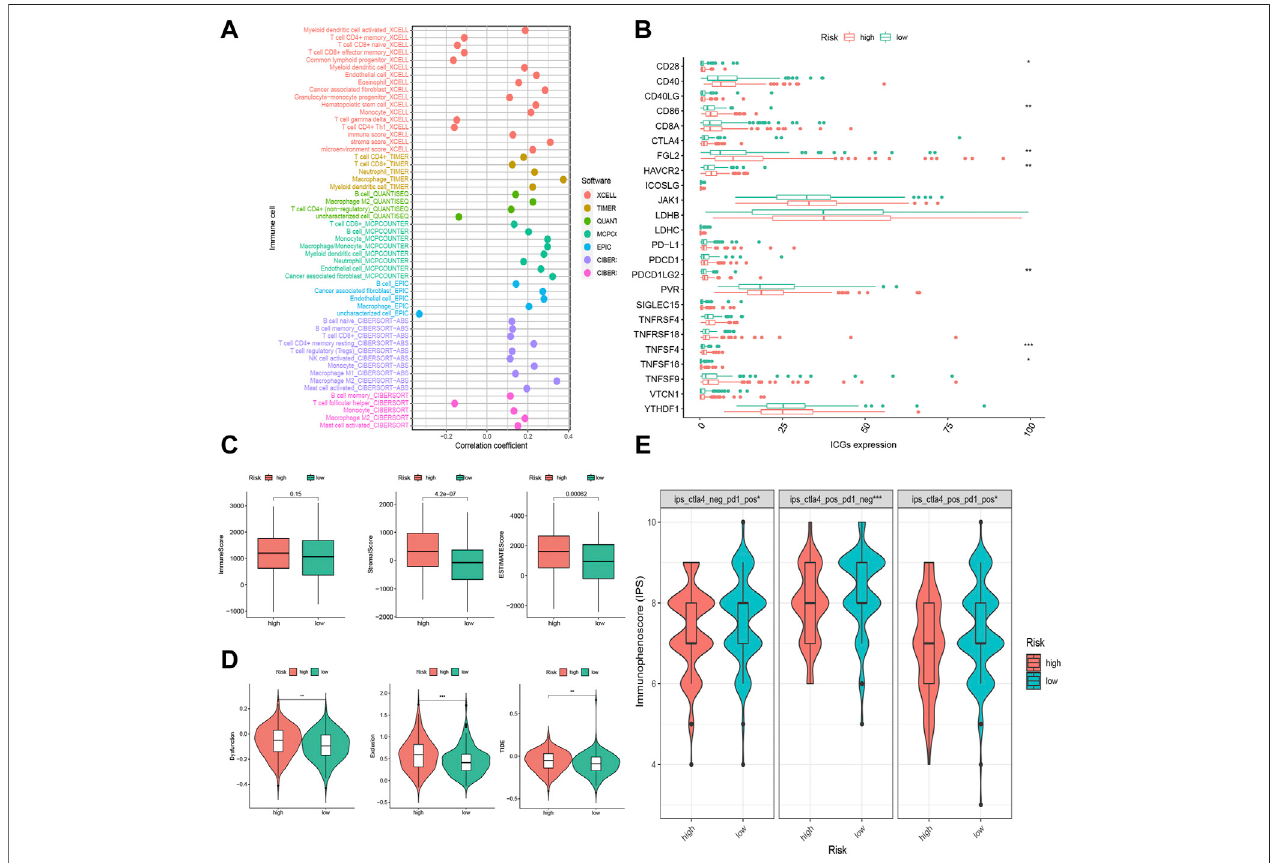
FIGURE 6 | Tumor in fi ltrating immune cells (TIICs) and immunotherapeutic sensitivity analysis of the FRLP risk score model. (A) The correlation between risk score and TIICs analyzed by seven different quanti fi cation methods of immune in fi ltration estimations including TIMER, xCell, quanTIseq, MCP-counter, EPIC, CIBERSORT- ABS, and CIBERSORT. (B) Expression of 24 immune checkpoint genes in high- and low-risk groups. (C) Boxplots showing immune score, stromal score, and ESTIMATE score in high- and low-risk groups. (D) Boxplots showing dysfunction score, exclusion score, and tumor immune dysfunction and exclusion (TIDE) score differences between high- and low-risk score groups. (E) Immunophenoscore (IPS) differences for ICB treatment between high- and low-risk groups; ips_ctla4_neg_pd1_pos refers toCTLA4-negative responseand PD1-positive response;ips_ctla4_pos_pd1_negreferstoCTLA4-positive